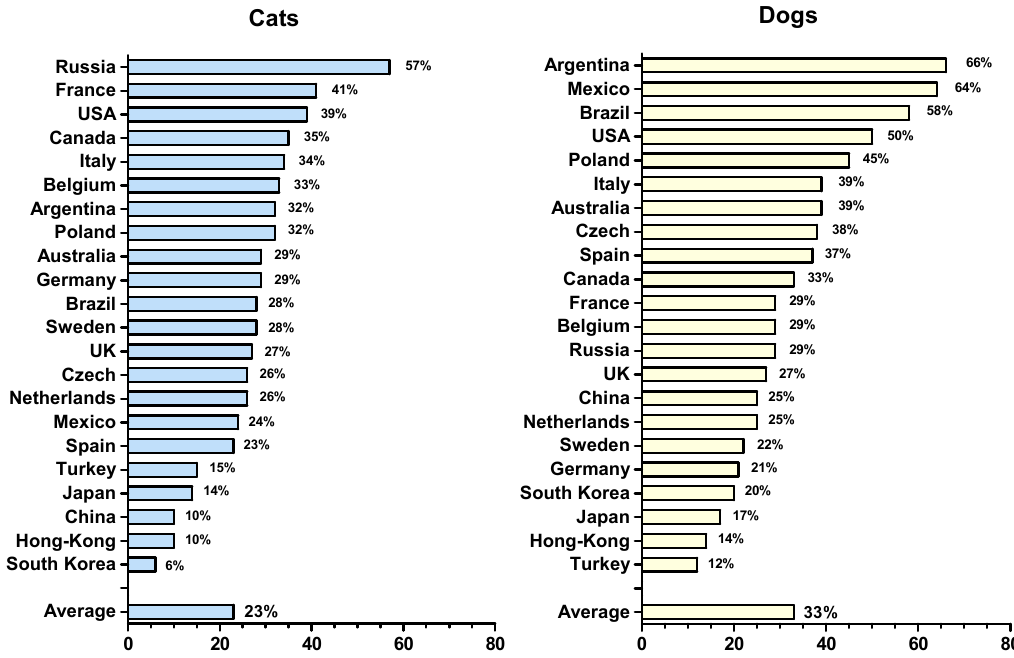
Figure 1. Frequency of cat and dog ownership in different countries ( based on Global GfK survey [3])